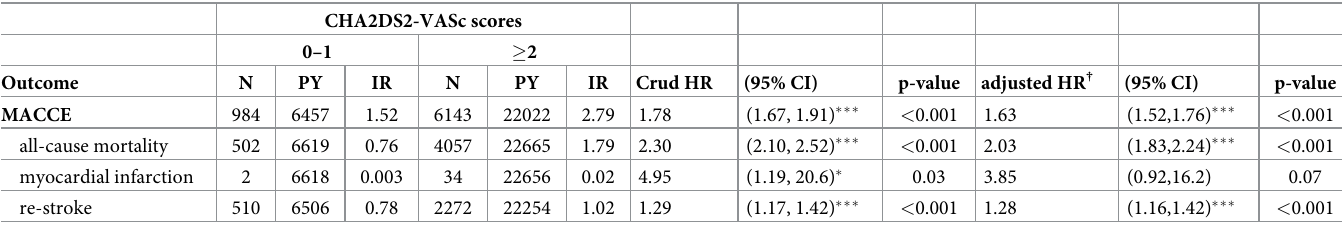
Table 2. The association of CHA2DS2-VASc score and 1 year outcomes.